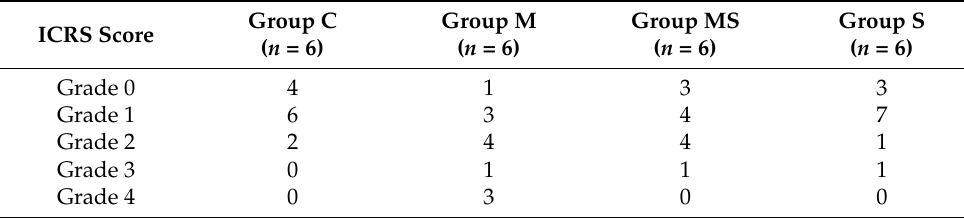
Table 2. The numbers of broilers with each gait